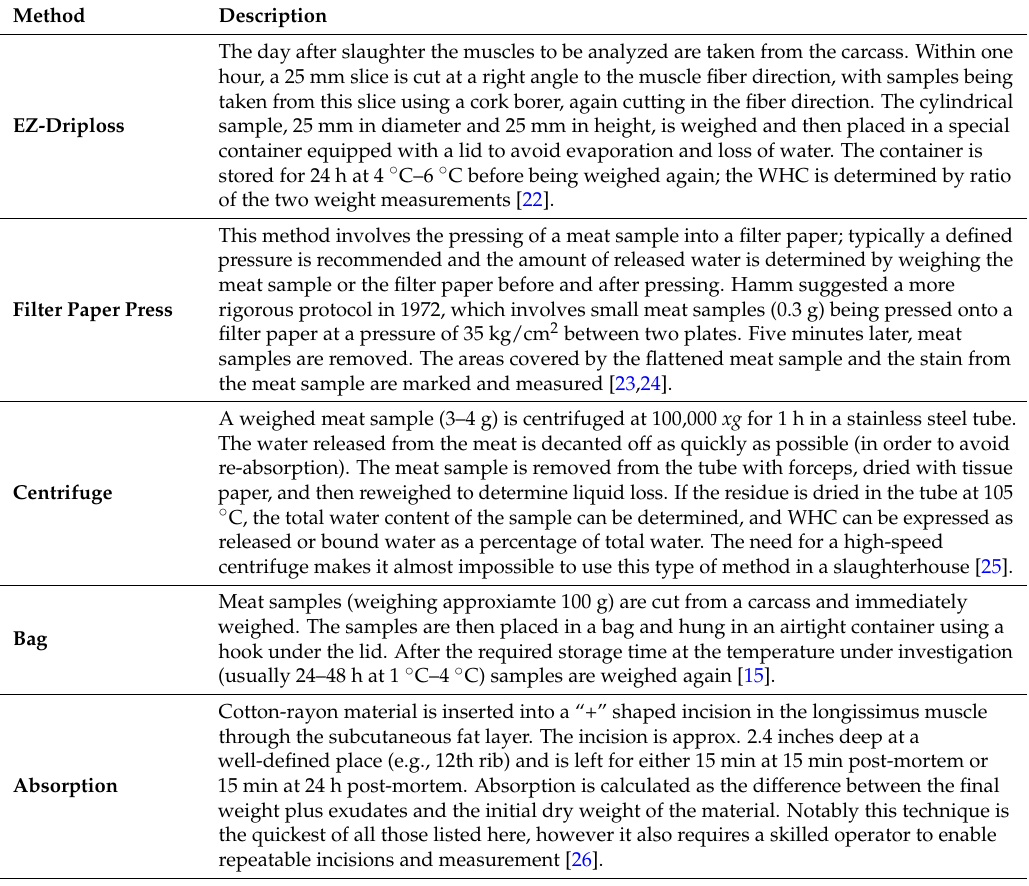
Table 2. Manual methods of measuring water holding capacity, or its reciprocal parameter, drip loss, used in the commercial and research